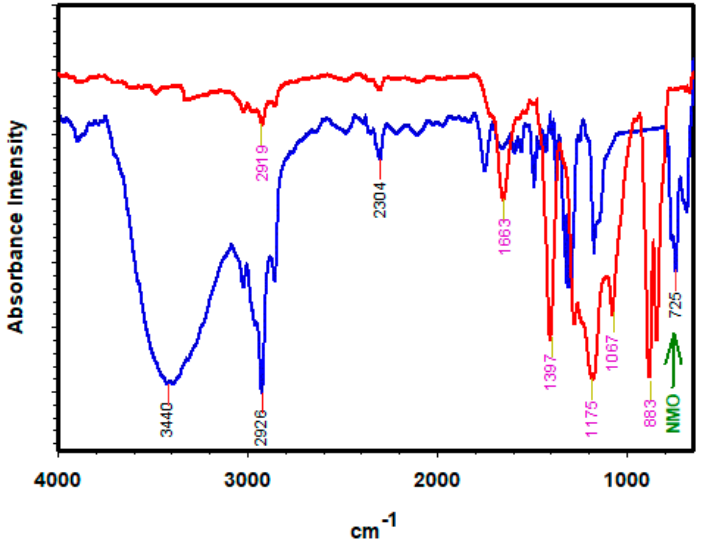
Figure 10. FTIR spectra of used neat membrane (red spectrum), and the modified membrane (blue spectrum).